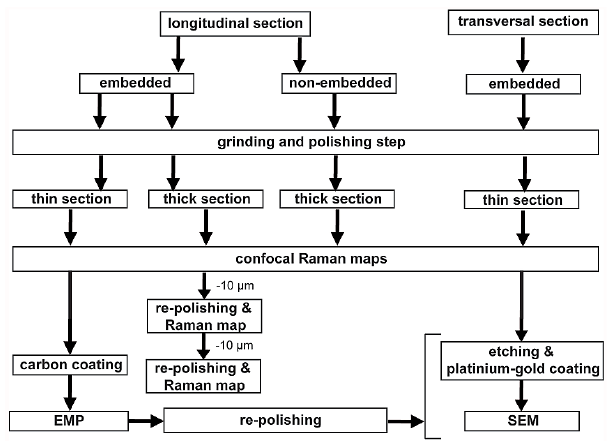
Fig. 2. Sample preparation and analysis overview. Flow chart dis- plays the chronology of the preparation and measurement steps for